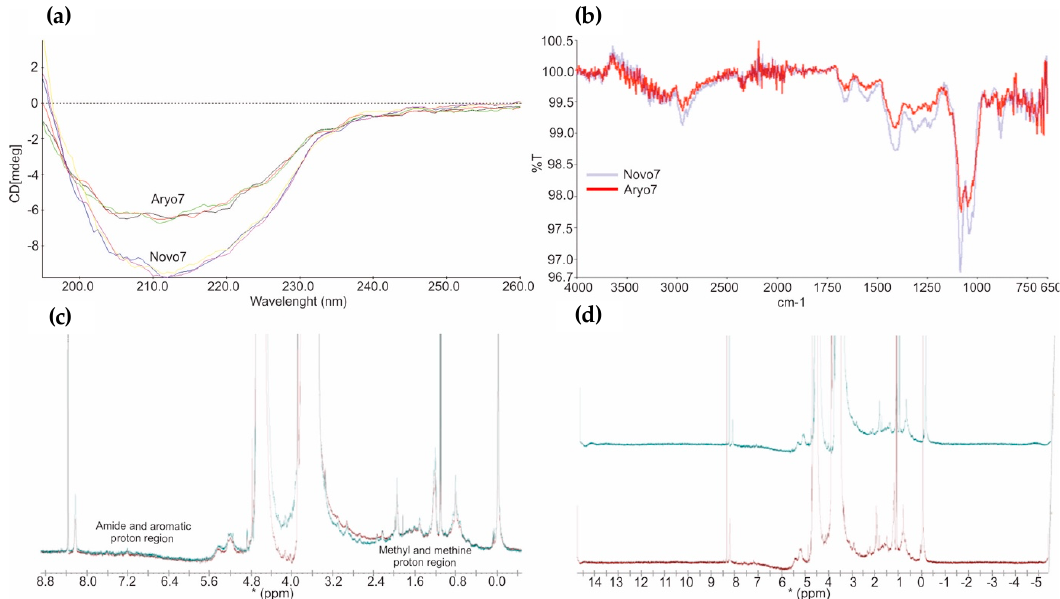
Figure 6. ( a ) The overlay of far-UV CD spectra obtained from innovator and AryoSeven™. ( b ) FTIR spectra indicating a high similarity of the amide I and II bands between both biologics (light blue; NovoSeven ® , and red, AryoSeven™). ( c , d ) NMR spectral fingerprinting showing all protons in methyl and methine region (zero to three parts per million) as well as amide and aromatic region (six to eight parts per million) (green, NovoSeven ®, and red, AryoSeven™). FTIR presents the vibrational state of biomolecules. Multiple IR bands (Figure 6 b) are produced from the backbone amide groups, which describe the backbone shape of biologicals. A comparable